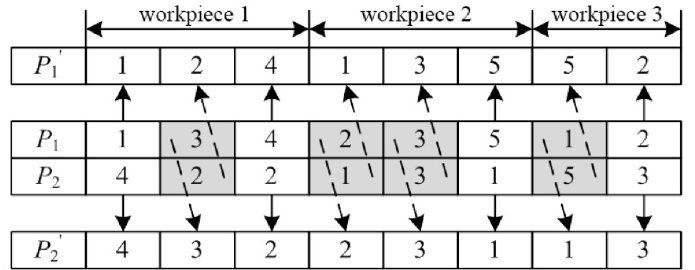
Figure 4. Crossover strategy of machine allocation